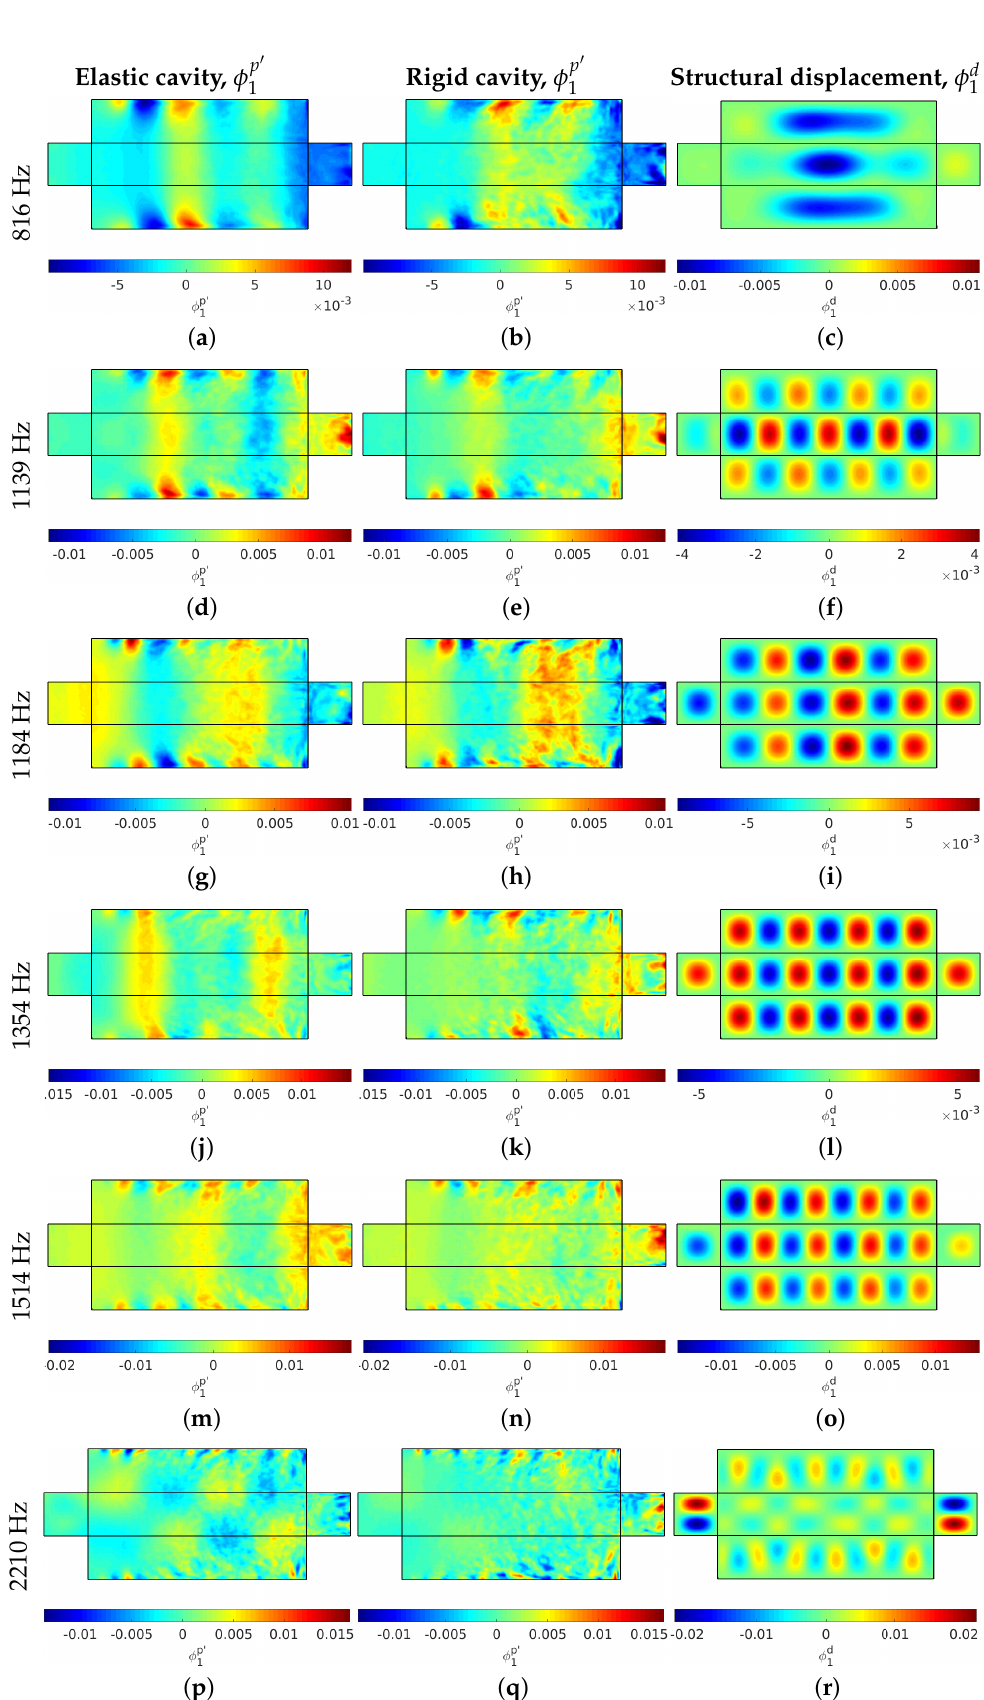
(cid:48) of the elastic cavity ( left column ), rigid cavity 1 ( rightcolumn )atfrequencies f = 1